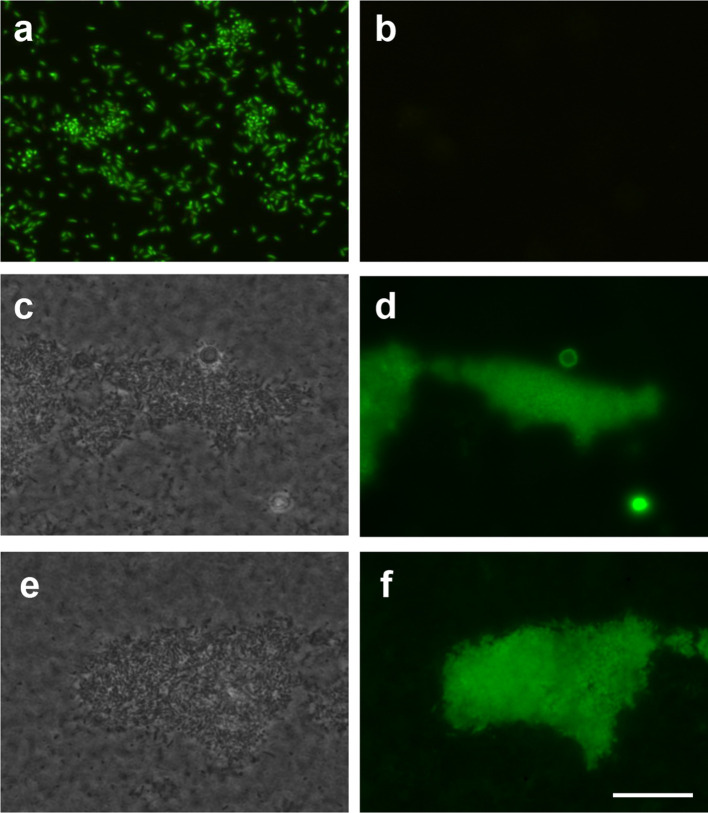

P. aeruginosa
 cultured in continuous-flow biofilms can stably integrate and express antibiotic resistance and gfp gene cassettes by natural transformation of exogenous chromosomal DNA. Sterile PAO1GFP gDNA (at a final concentration of 0.1 mg ml−1 with flow rate of 80 µg min−1) was added to the media influent of continuous-flow biofilms of PAO1 in (a) Tygon tubing or (c–f) flow cells and incubated for 5 days. (b) The inoculum PAO1 strain did not express GFP. (a) Gentamicin resistant (GmR) colonies obtained from Tygon tubing biofilms were resuspended in PBS and visualized by epifluorescence microscopy, which showed all cells from GmR colonies expressed GFP. (c–f) The biofilm biomass from PAO1 flow cells was visualized by phase contrast (c, e) or epifluorescence microscopy (d, f), which showed the presence of representative biofilm microcolonies expressing GFP. Scale bar 100 µm.